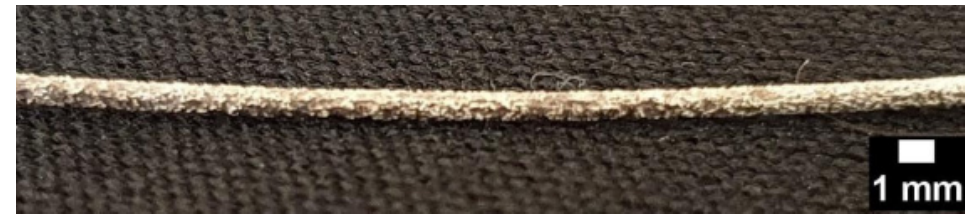
Figure 10. Specimen after 168 h